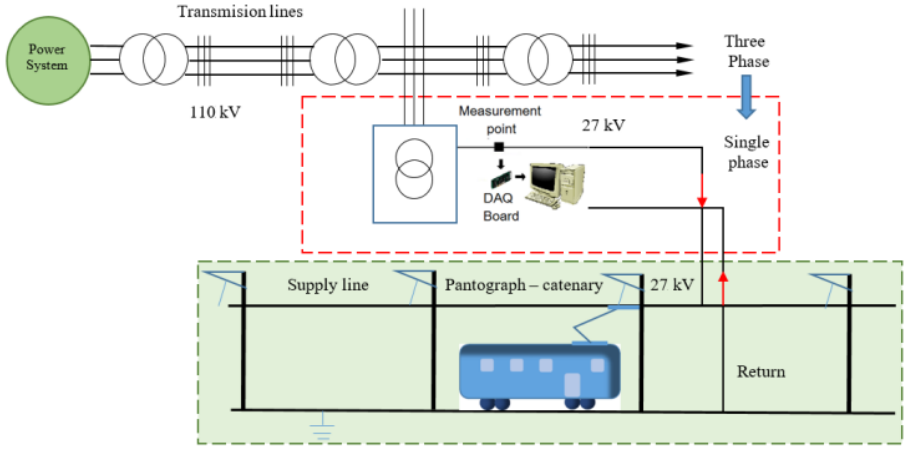
Figure 1. The measurement scheme.